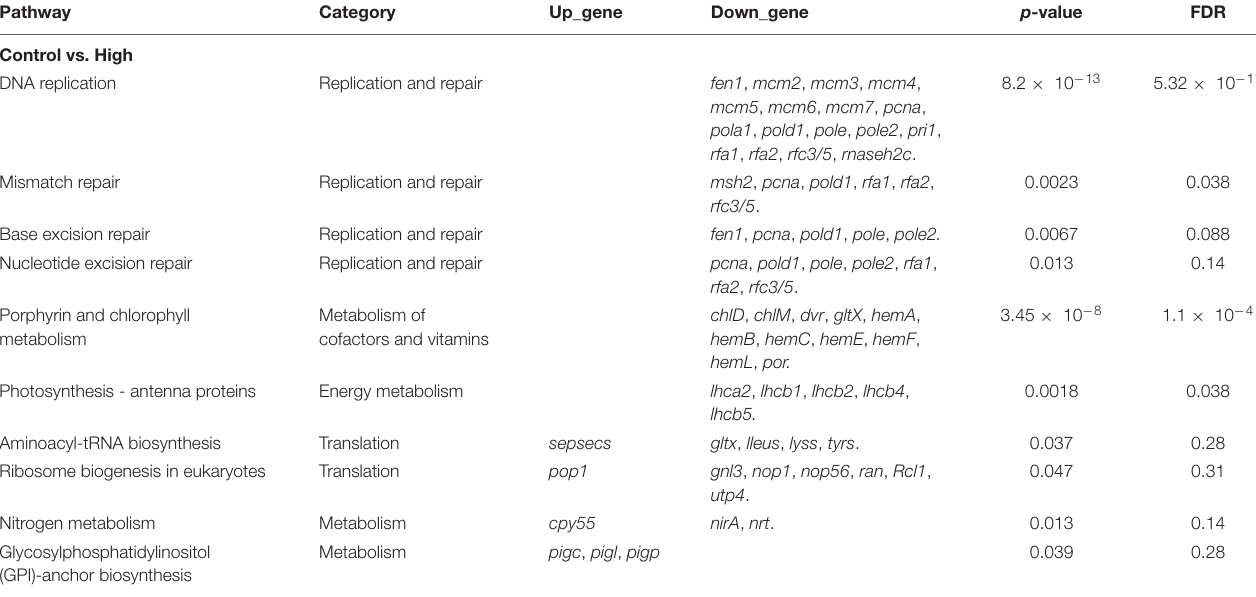
TABLE 1 | List of key enriched pathways ( p < 0.05) in R. subcapitata treated with 300 µ g L − 1 of sulfamethoxazole. Pathway Category Control vs.